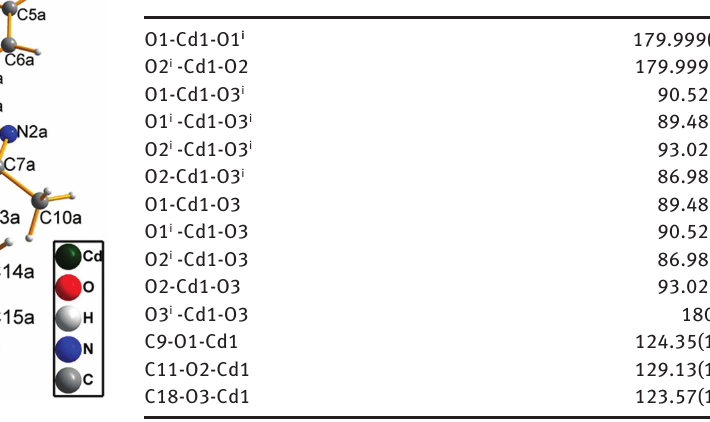
Table 2: Selected angles ( ° ) for the